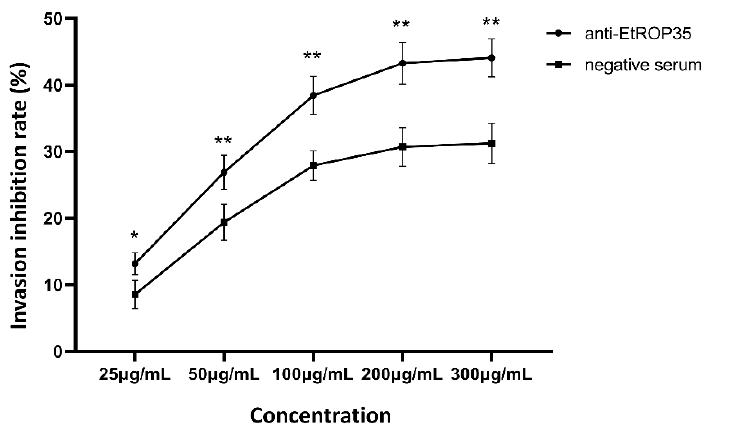
Figure 4. Anti-EtROP35 polyclonal antibody inhibits sporozoites invading into the host cells. Invasion inhibition rate = (uninvaded sporozoite number in the serum group/uninvaded sporozoite number in PBS group − 1) × 100%. Significant difference: * p < 0.05, ** p < 0.01.